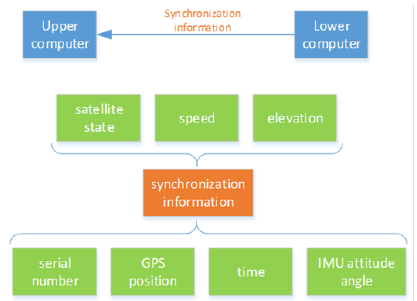
Figure 6. The structure of synchronization information